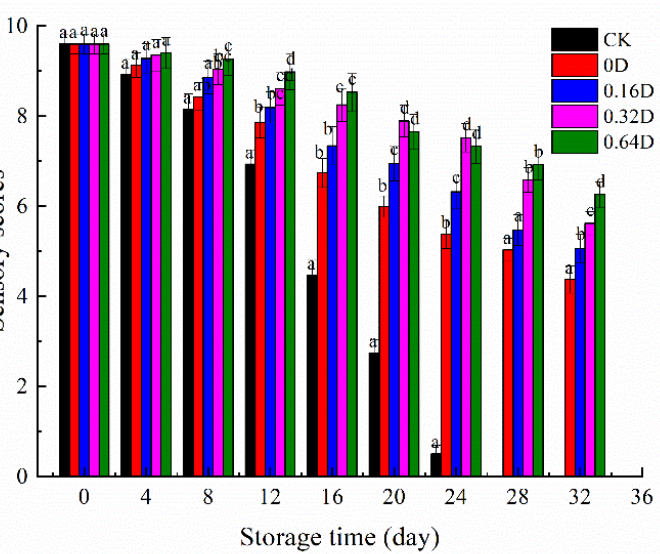
Figure 7. Changes in the sensory scores of turbot samples during refrigerated storage. Different superscript letters a–d indicate significant differences ( p < 0.05) .